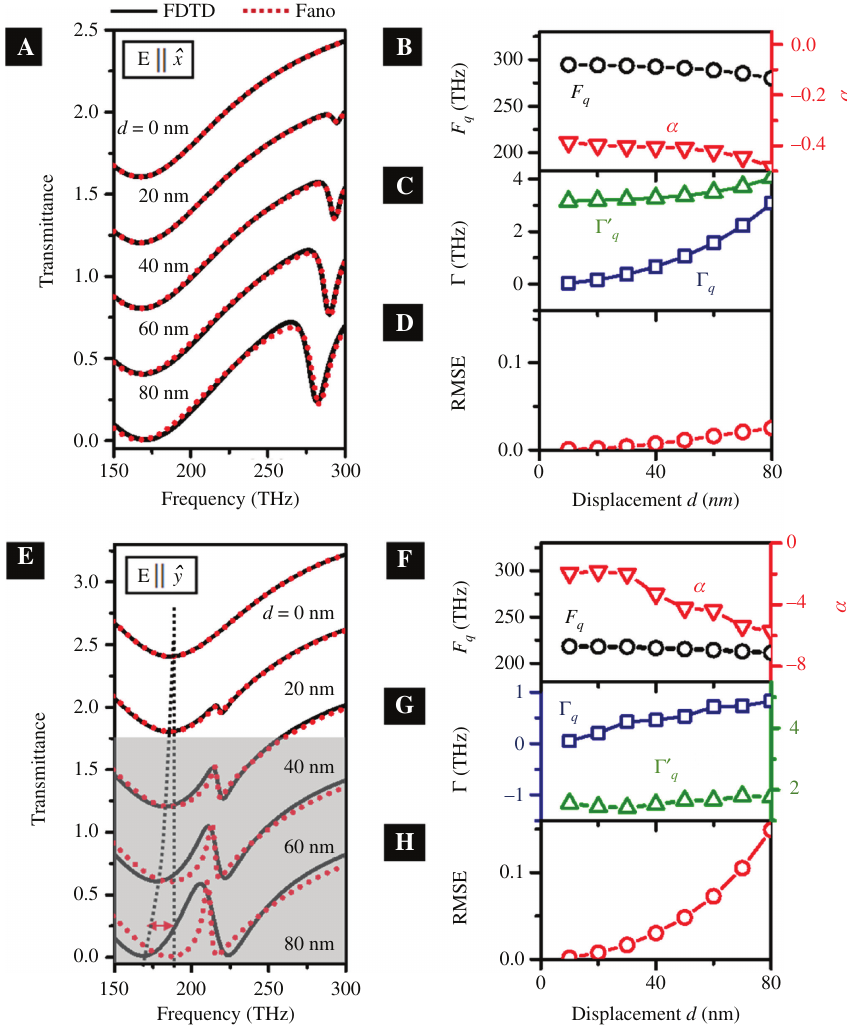
Figure 4: Analyses on the applicability of Fano’s formula. (A, E) FDTD-simulated (solid black curves) and Fano-formula-fitted (red dotted curves) spectra of samples with different values of d , shined by normally incident lights with two different polarizations. (B−C, F−G) Retrieved Fano-formula parameters as functions of d . (D, H) RMSE between the Fano-fitted and FDTD spectra as functions of d in two different d for both polarizations. While RMSE remain at very small lines in Figure 4A and E. The retrieved Fano parameters are values for all the cases studied under x -polarization, they depicted in Figure 4B, C and 4F, G. Compared with the FDTD become significantly enlarged for the y -polarization cases spectra, the Fano spectra can reproduce all FDTD spectra with d > 40 nm. We emphasize that such deviations cannot with x -polarization well, but exhibit significant deviations be diminished by varying the fitting parameters, but rather for the y -polarization cases, especially for samples with are caused by the fact that the bright-mode dip in FDTD d > 40 nm. Such deviations are more clearly seen in Figure 4D simulated y -polarized spectra exhibits a clear red shift as d and H, where the root-mean square errors (RMSE) 5 between increases. The latter can never be modeled by Fano’s formula the Fano and FDTD spectra are depicted as functions of [Eq. (1)] assuming a “passive” background. Apart from the issues arising in the fitting processes, another problem is that Fano’s theory cannot tell us why where t and t is the transmit- theory FDTD the fitting parameters should behave like those depicted in tance amplitude of corresponding theoretical formula and FDTD Figure 4B, C and 4F, G, which are important to understand simulation, and the light’s frequency from f to f are our considering 1 2 the underlying physics. For example, it is very difficult to waveband. γ is the radiation loss rate of the bright mode. p